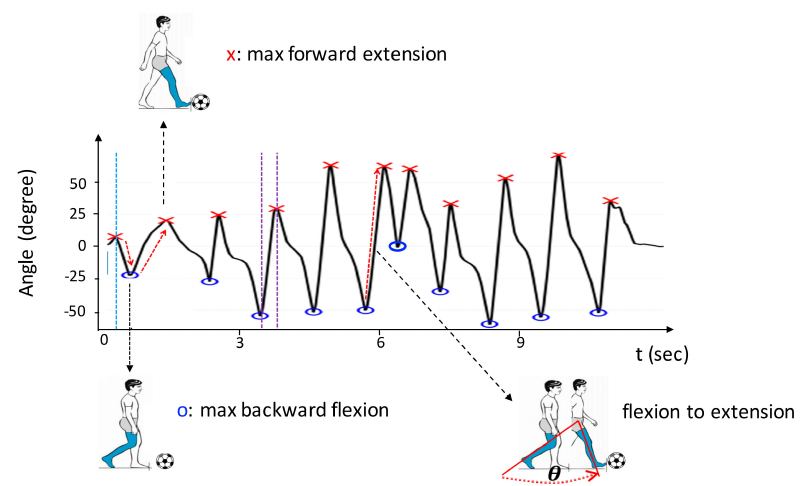
Figure 7. Illustration of the swinging angle measured from the right_calf on the sagittal plane. The angle from a valley point (blue circle) to a peak point (red cross) represented the degree through which the participant swung the calf